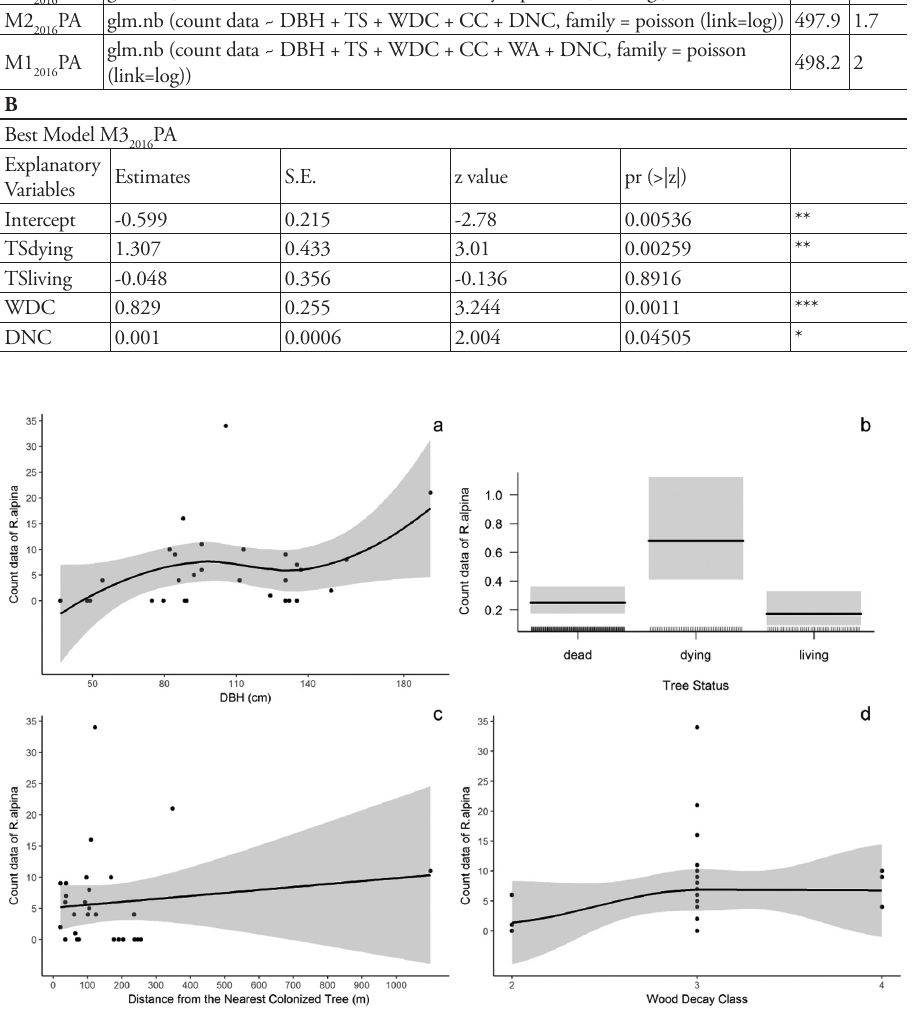
Figure 10. Figure shows the significant environmental variables of the fitted GLM models, on count data of R. alpina in PA during 2015. In figures A), B) and D) LOESS (locally weighted scatter plot smoothing) function has been used. A larger number of individuals was observed on trees with DBH greater than 80 cm, dying, belonging to the middle-advanced decay status and distance less than 300 m from other colonised